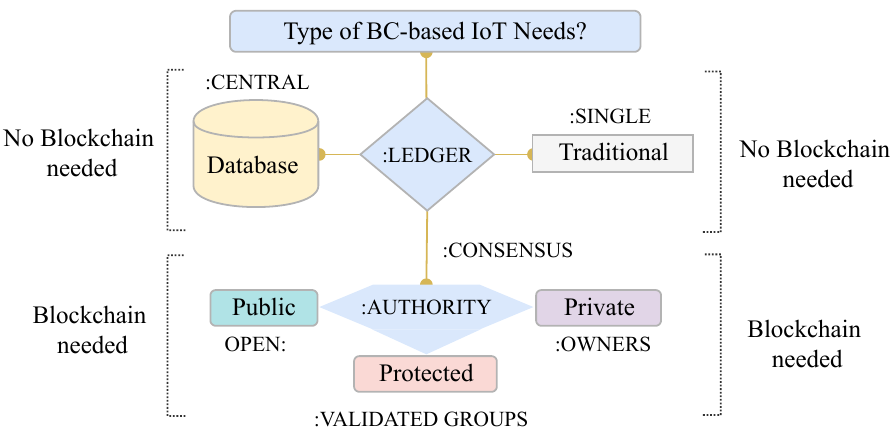
Figure 2. The classification of BCs according to the requirement